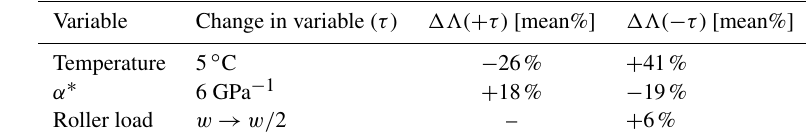
Table 2. Summary results of the sensitivity analysis. Mean percentage changes to (cid:51) values, resulting from specified changes to each vari- able’s “standard value”, are given.